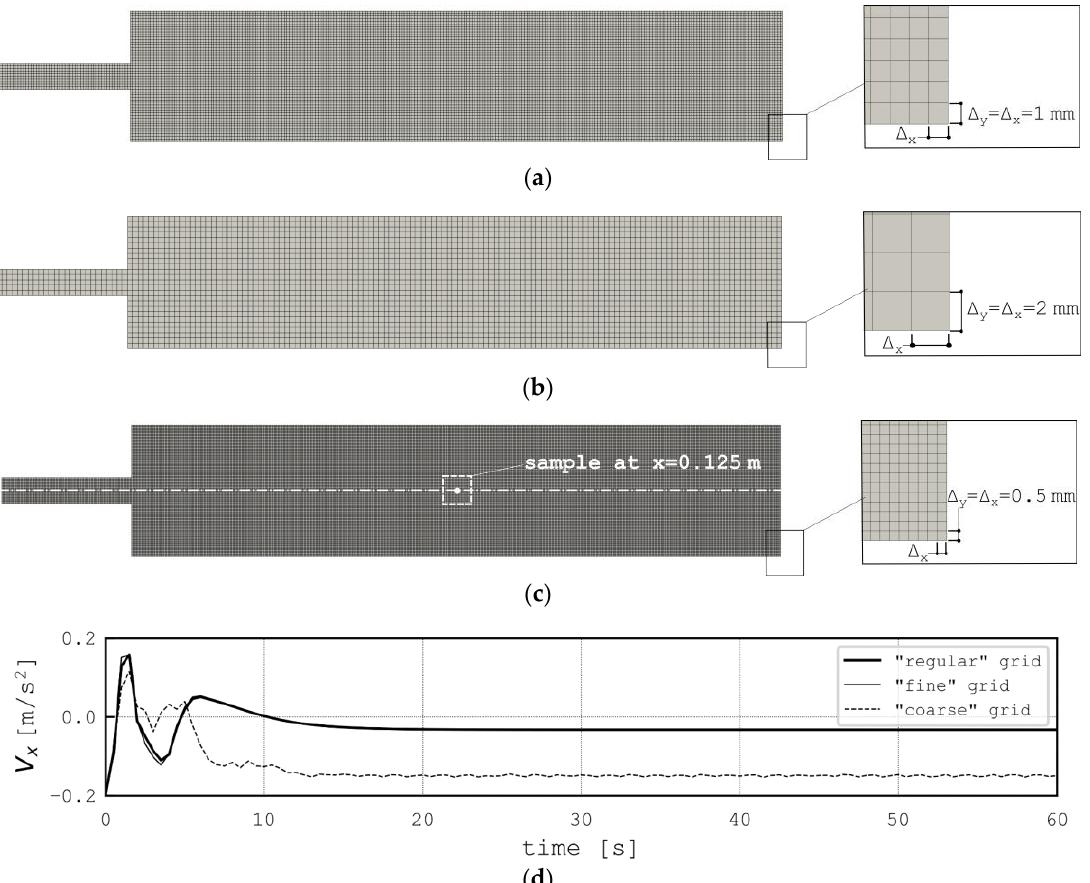
Figure 1. Computational grid used for grid independence validation. ( a ) grid used for calculation & analysis; ( b ) “coarse” grid which doubled the step size compared with the grid used; ( c ) “fine” grid which halved the step size compared with the grid used; ( d ) evolutions of velocity sampled at the geometry center of expanded channel.